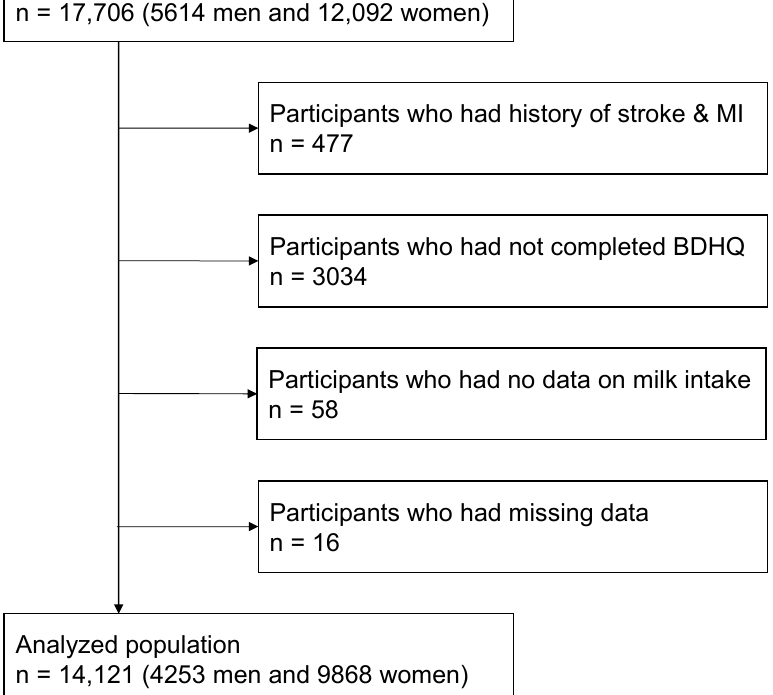
Figure 1. Flowchart for the selection of analyzed cohort.